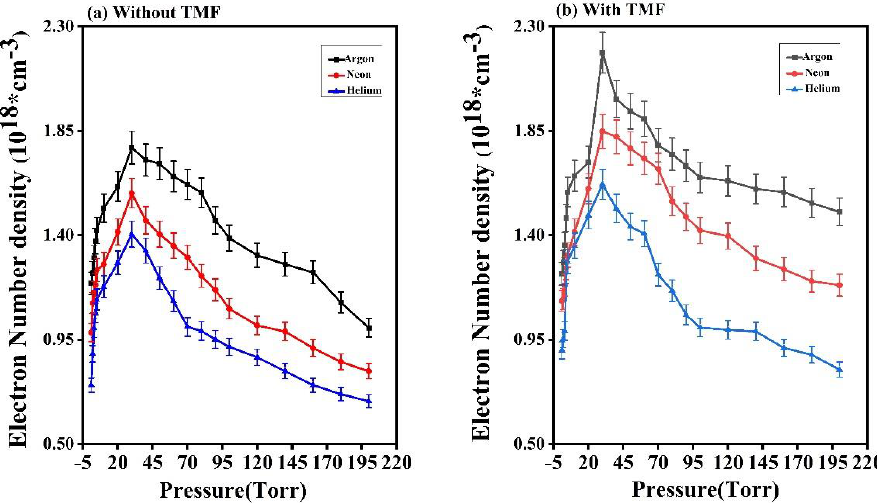
Figure 7. The variation in n e of laser-induced Cu-alloy plasma at various pressures under Ar, Ne, and He environments at an irradiance of 3.8 GW/cm 2 in the absence ( a ) and presence ( b ) of TMF.